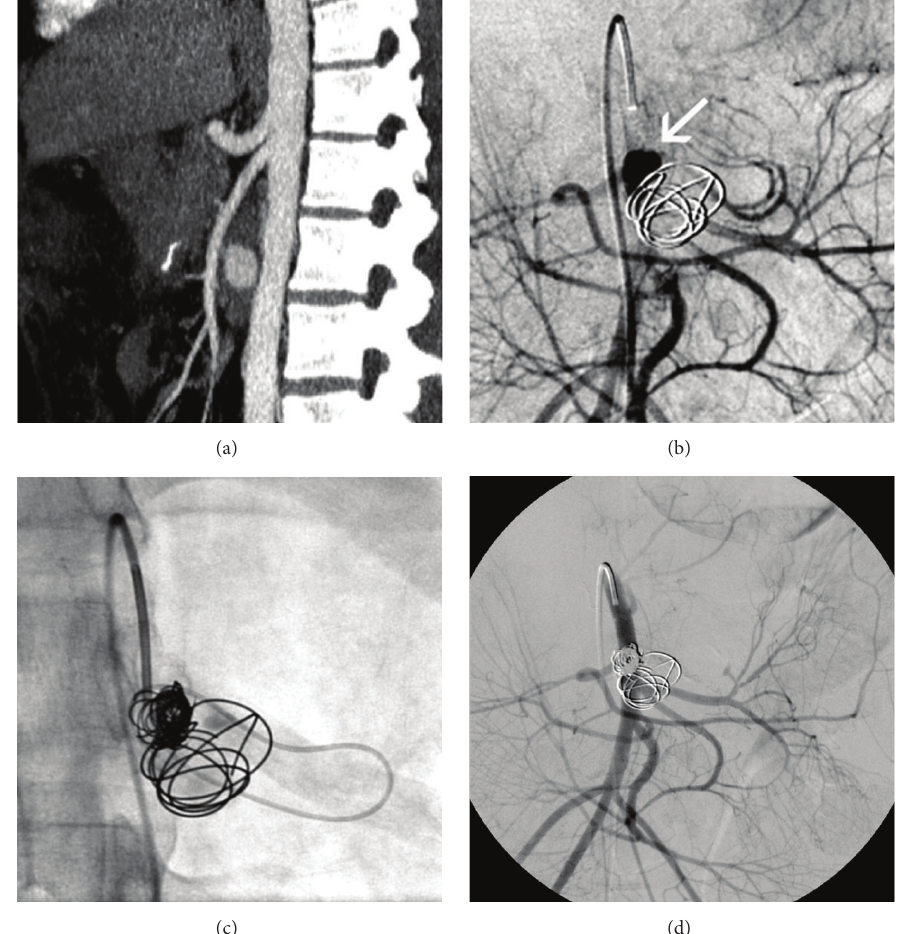
Figure 1: 34-year-old woman presenting a jejunal artery pseudoaneurysm treated by transcatheter embolization via collaterals vessels. (a) Sagittal contrast enhanced CT image showing a pseudoaneurysm emerging from the first SMA branch (jejunal artery) just after its origin. (b) Digital angiogram obtained after coil embolization shows that pseudoaneurysm is still partially patent (white arrow) requiring further embolization; however subsequent direct catheterization was not possible. The image shows a collateral vascular arc between the first and the second jejunal arteries. (c) The collateral vascular arc was used to obtain pseudoaneurysm catheterization. (d) Complete embolization was finally